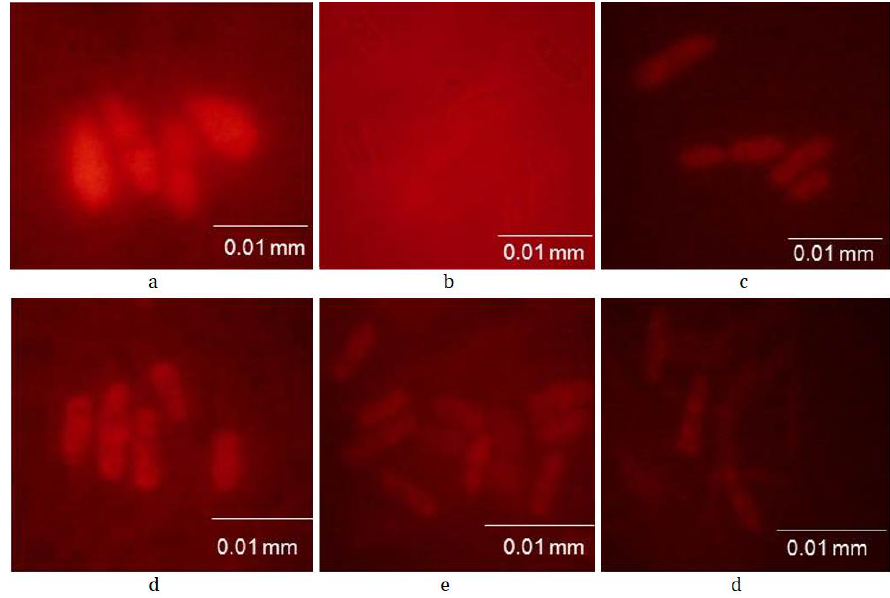
Figure 7. Effect of phytoexracts derived from the vegetative organ parts of X. granatum on mitochondrial activity of yeast S. pombe : (a) EMM 0.5% of glucose (control +, 0 µg.mL -1 ), (b) YES 3% of glucose (control -, 0 µg.mL -1 ), (c) YES 3% of glucose + 250 µg.mL -1 of root phytoextract, (d) YES 3% glucose + 250 µg.mL -1 of stem phytoextract, (e) YES 3% glucose + 250 µg.mL -1 of leaf phytoextract, and (f) YES 3% glucose + 250 µg.mL -1 of twig phytoextract. Bar in each picture represents 10µm scale.